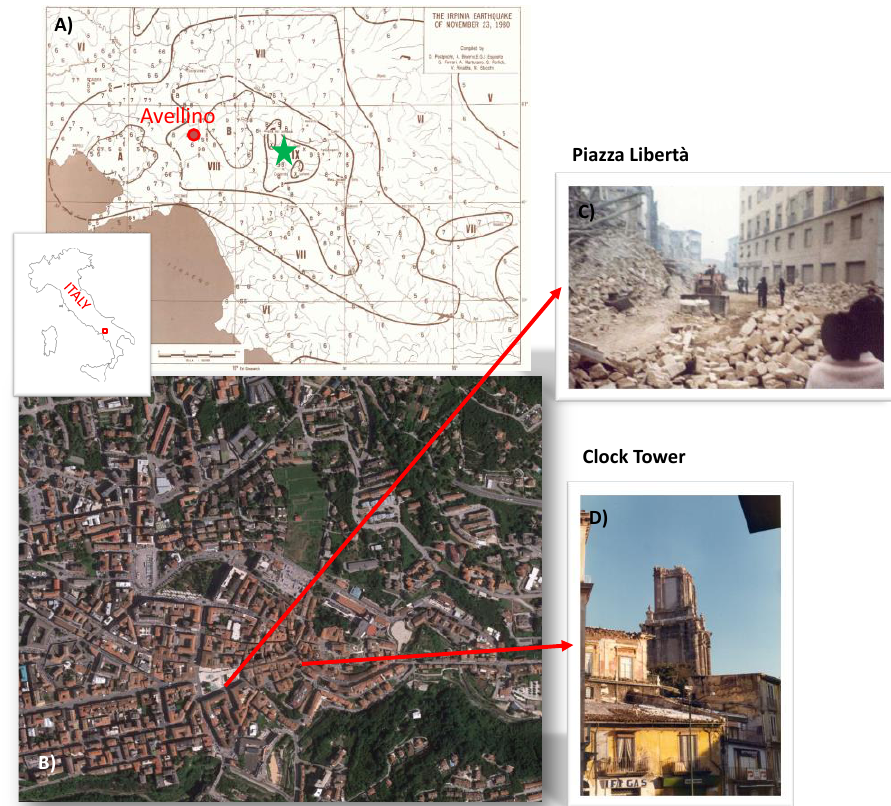
Figure 1. ( A ) Isoseismal lines of the 23rd November 1980 Irpinia-Basilicata earthquake (modified after [3]). The green star identifies the epicenter of the earthquake. ( B ) Geographical localization of the